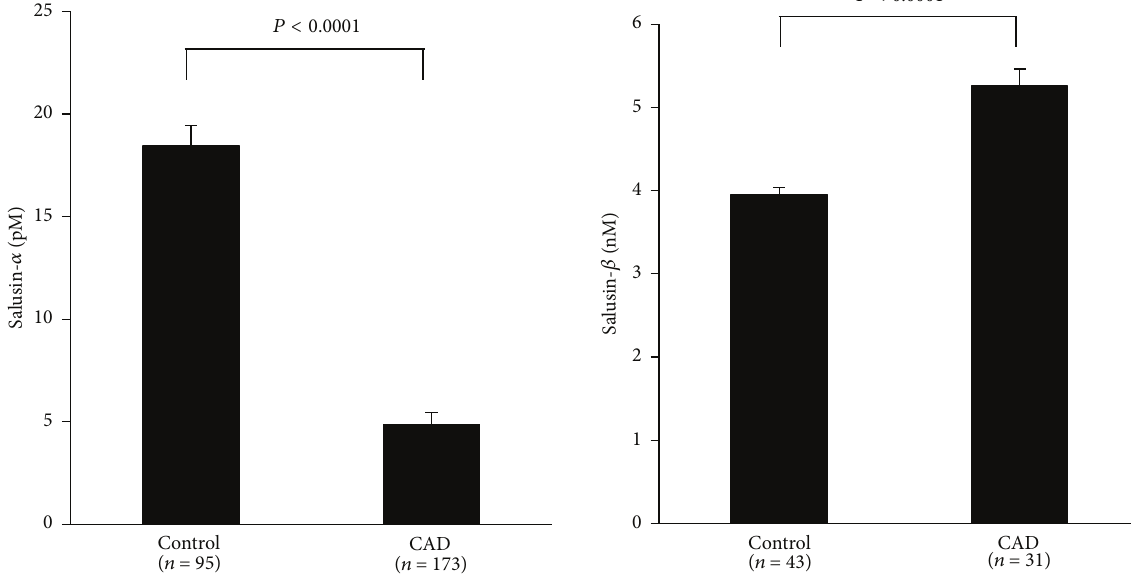
Figure 3: Comparison of circulating levels of salusin- 𝛼 and salusin- 𝛽 between non-CAD subjects and CAD